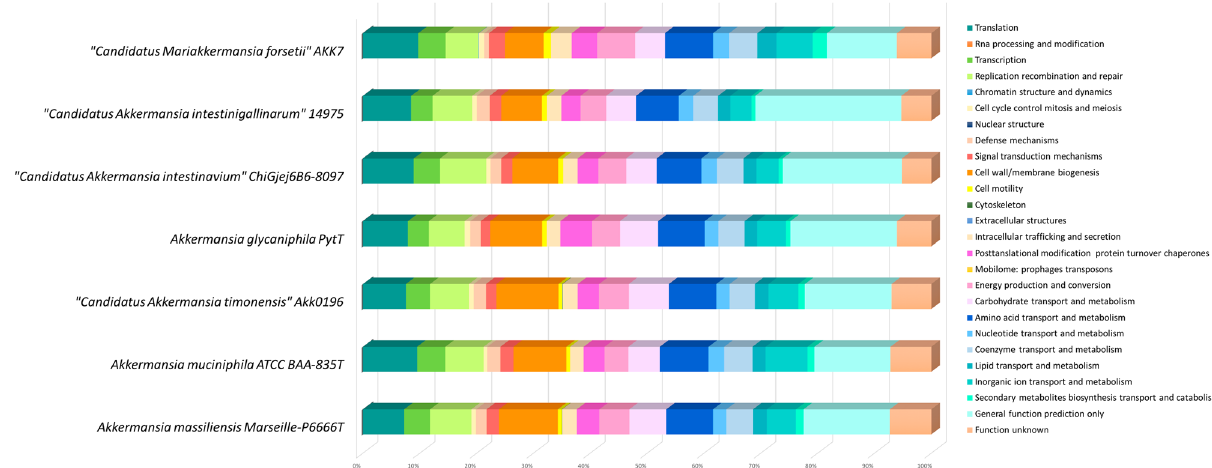
Figure 3. Distribution of predicted protein-coding genes from Akkermansia muciniphila strain ATCC BAA- 835 T (Cluster I), Akkermansia massiliensis strain Marseille-P6666 (Cluster II), “ Candidatus Akkermansia timonensis” strain Akk0196 (Cluster III), Akkermansia glycaniphila strain Pyt T , and other closely-related species, in COG